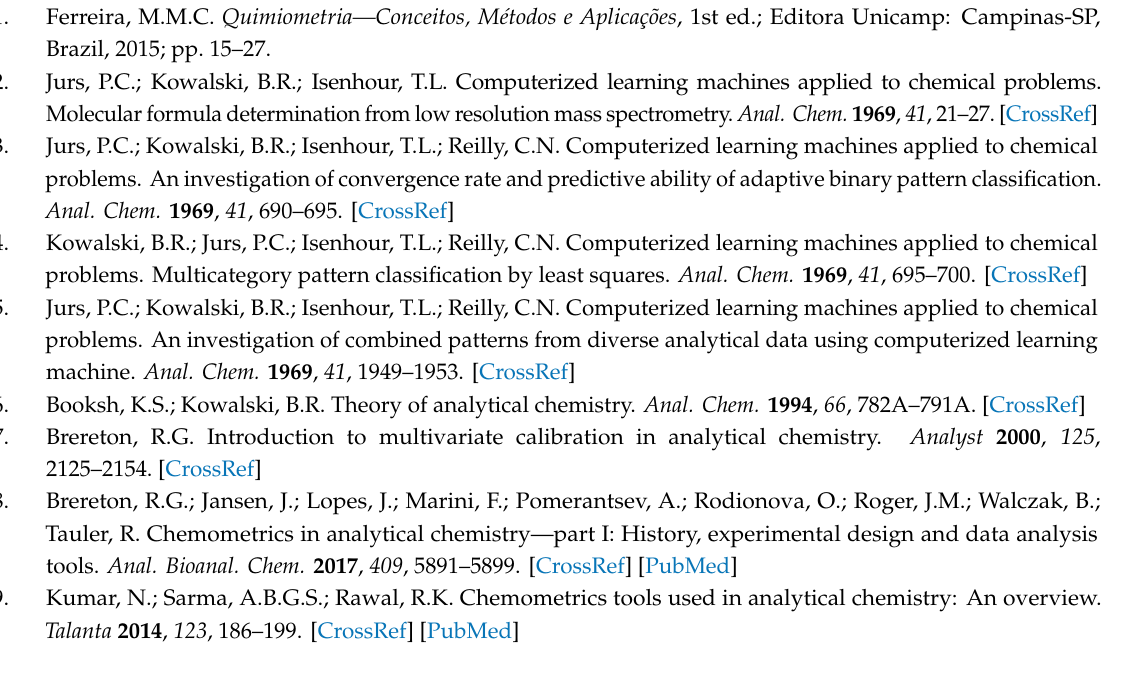
Supplementary Materials: The supplementary materials are available online. Table S1: UV absorption of oil samples heated at 150 ◦